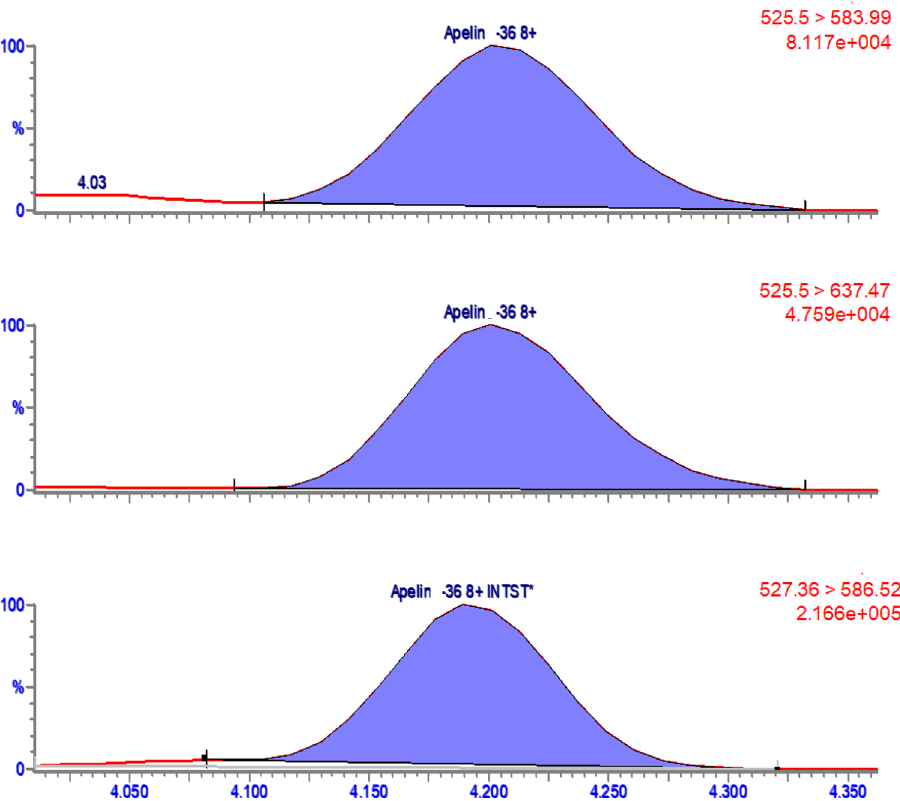
Figure 8. Chromatogram of the two MRM transitions of apelin-36 (the 2 top chromatograms) and its SIL internal standard (bottom chromatogram) in the transfected HEK cells. Additional chromatograms are in Supplementary Fig. S3.